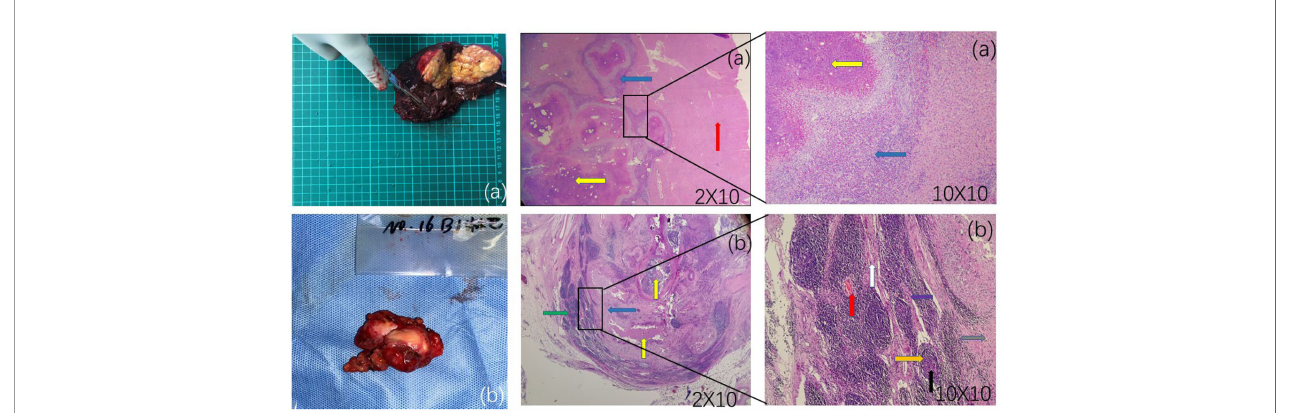
FIGURE 2 | (A) A cheese-like or milky-yellow section of the liver specimen with a hard surface. Postoperative liver pathology observed under different magni fi cations of microscopy: red arrows show normal liver tissue, yellow arrows show hepatic vesicular echinococcosis lesions, and blue arrows show alveolar echinococcosis reaction zones containing in fl ammatory cells such as eosinophils, lymphocytes and fi broblasts. (B) An enlarged lymph node adjacent to the inferior vena cava- abdominal aorta. Postoperative lymph node pathology microscopically observed at different magni fi cations: yellow arrows show lymph node alveolar echinococcosis lesions, and blue arrows show the reaction zone. A wider reaction zone indicates longer invasion time. More surrounding fi brous tissue is seen, with more fi broblasts and fewer eosinophils, lymphocytes, and epithelioid cells. A narrower the reaction zone indicates shorter invasion time, with fewer corresponding fi broblasts and more eosinophils, lymphocytes, and epithelioid cells. Lymphocytes and epithelial-like cells are increased. Purple arrows show macrophages, red arrows show blood vessels, black arrows show lymph node germinal centres, orange arrows show lymphoid follicles, grey arrows show epithelioid cells, white arrows show fi brous structures of lymph nodes, and green arrows show lymphatic tissue perithelium. Postoperative pathology shows alveolar echinococcosis within the lymphoid